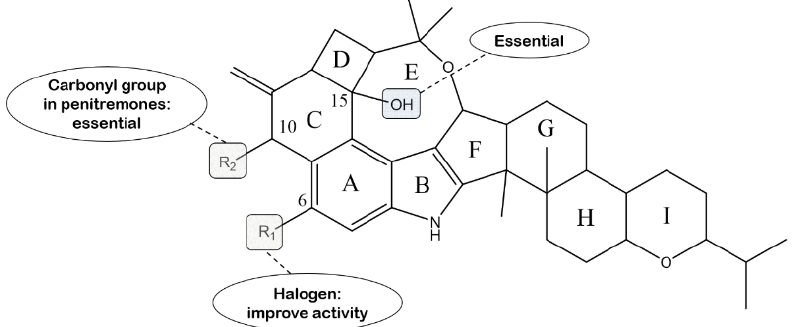
Figure 20. Structure – tremorgenic activity relationship of penitrem indole diterpenes.